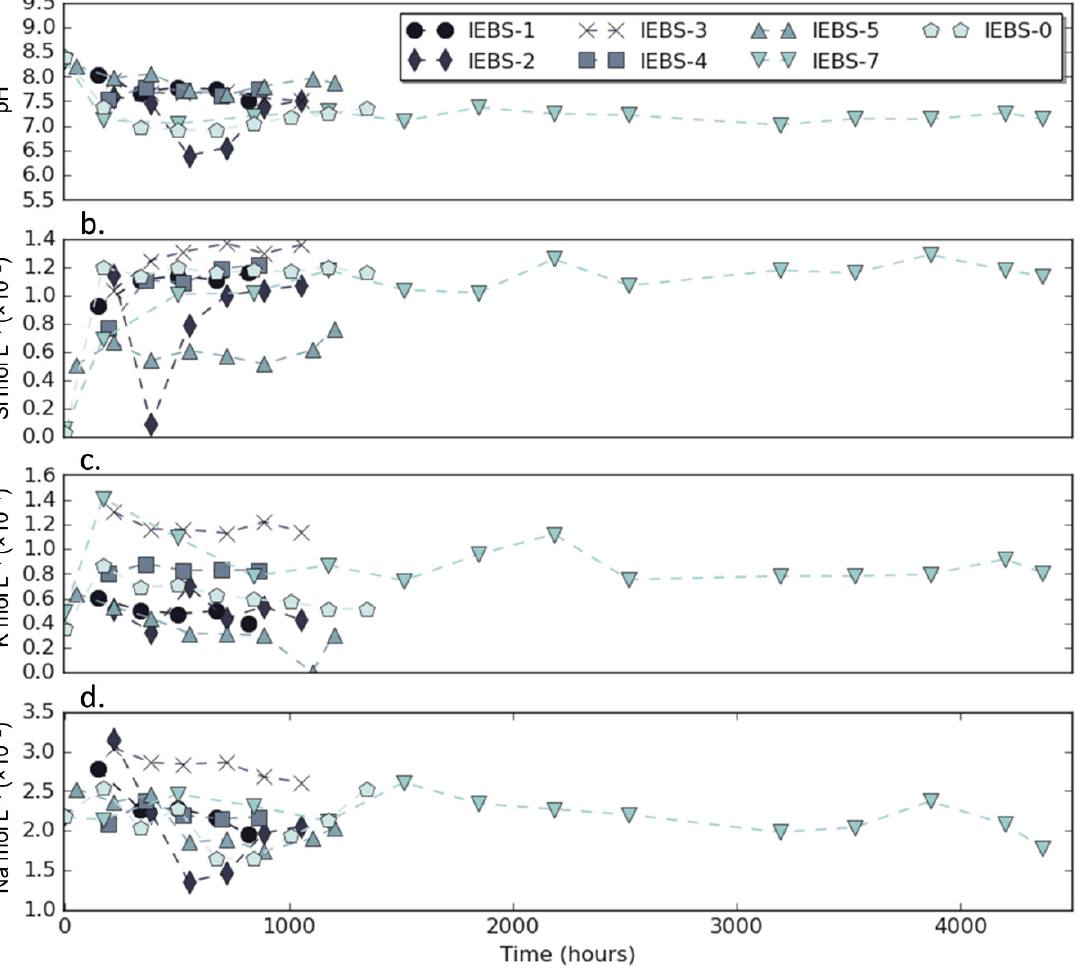
Figure 1. Results of fluid sample analyses showing ( a ) In situ pH, ( b ) silica concentrations in mol L − 1 , ( c ) potassium concentrations in mol L − 1 , and ( d ) sodium concentrations in mol L − 1 . Error bars of 1 σ standard deviation are within the symbol size.